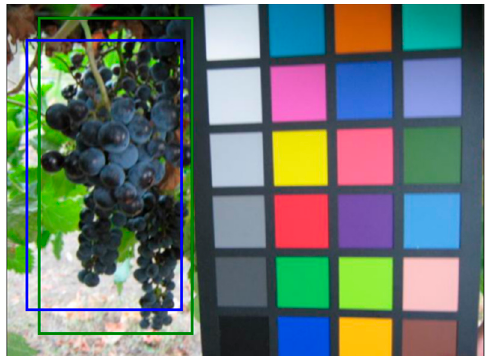
Figure 12. Example of correct detection on a test image from the GrapeCS-ML dataset. The green box represents the ground truth while the blue one is the detection results. The IoU of the two boxes is greater than 0.5.